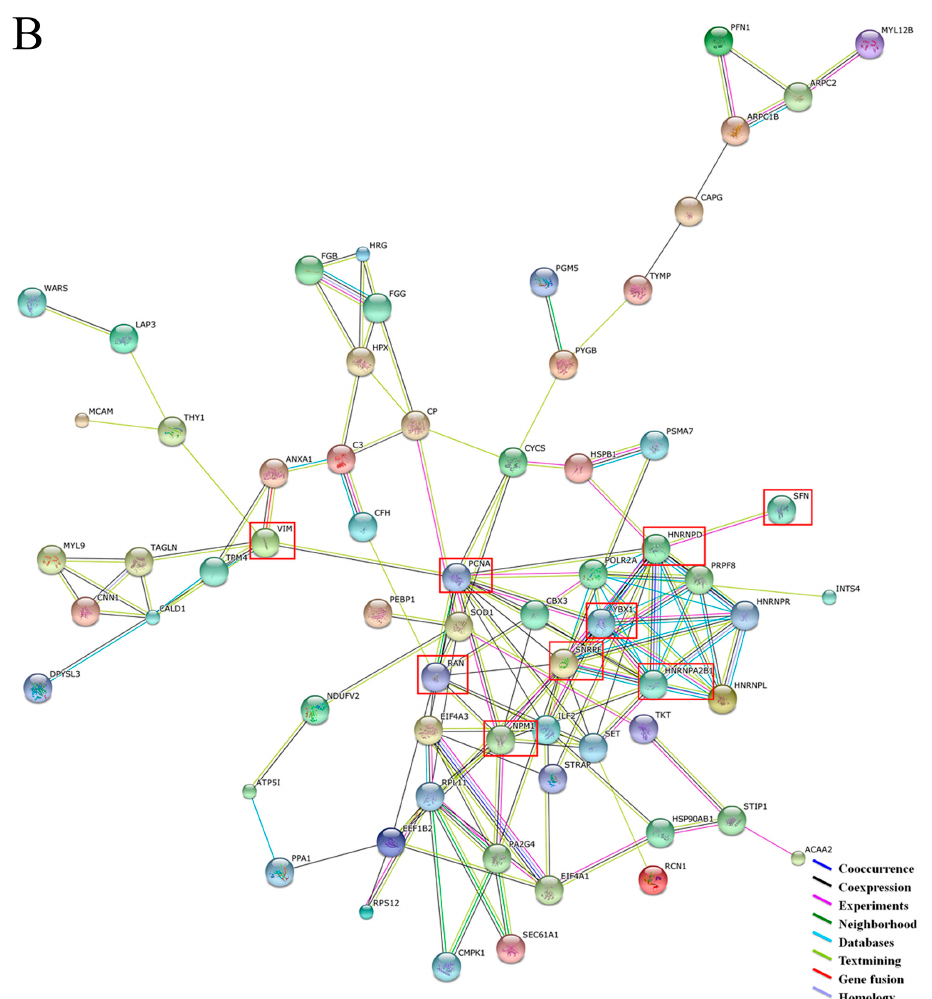
Figure 4. Protein-protein interactions (Evidence Mode) of dysregulated proteins were predicted by STRING. ( A ) Protein-protein interaction network formed with 146 dysregulated proteins. The three possible systematic dynamic clusters were indicated in red circles; ( B ) The network predicted 65 upregulated proteins. Some important proteins dispersed and located in the keynotes were marked with a red box. Different line colors represent the types of evidence for the association.